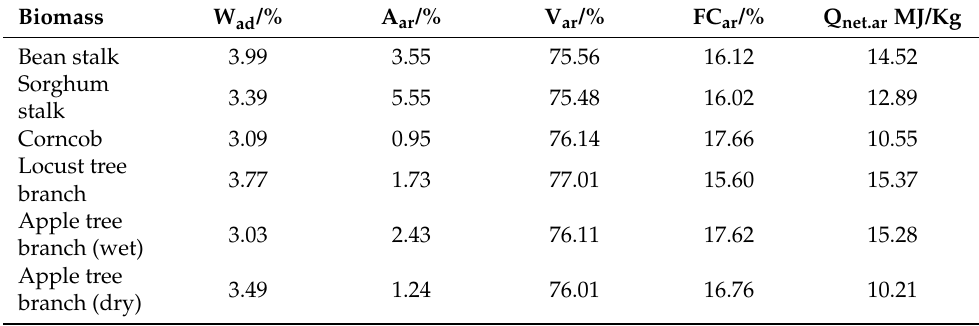
Table 2. Proximate analysis and heating values of available biomass